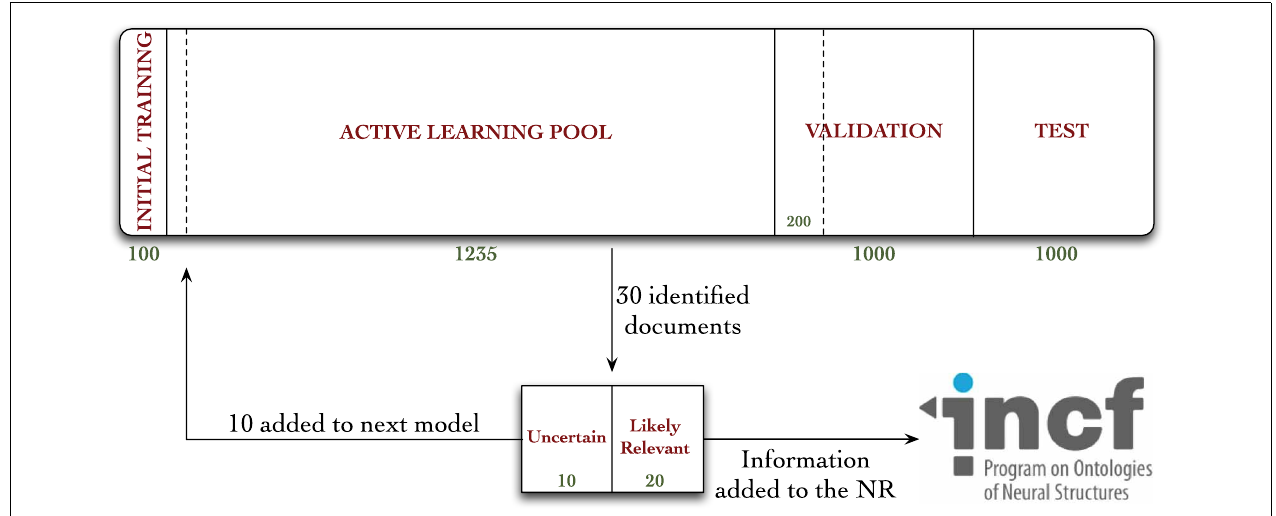
FIGURE 1 | Diagrammatic representation of the distribution of documents in our corpus, and workflow diagram for annotation in the active learning experiment. Documents were randomly allocated to either the initial training, active learning pool, validation, or test collections. A total